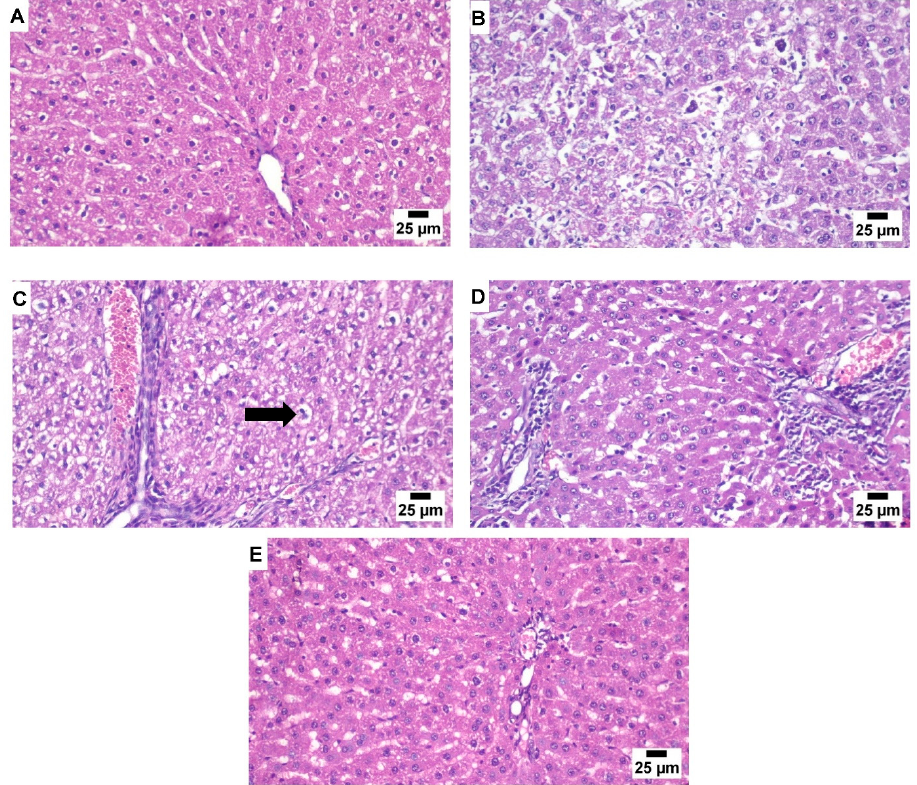
Figure 4. ( A ) The control group’s hepatic tissue has normal histological structure with radiating cords of hepatocytes surrounding the central vein. ( B ) Liver tissue from the Cisplatin group showing necrosis of the hepatic hepatocytes with evidence of dysplastic changes. ( C ) Liver tissue from the BM-MSCs group showing moderate vacuolated hepatocytes (arrow). ( D ) Liver tissue from the GGE group showing portal inflammation. ( E ) Liver tissue from the GGE and BM-MSCs combined group showing an apparently normal portal area with healthy adjacent hepatocytes ( n = 5). The administration of cisplatin resulted in serious histopathological alteration.